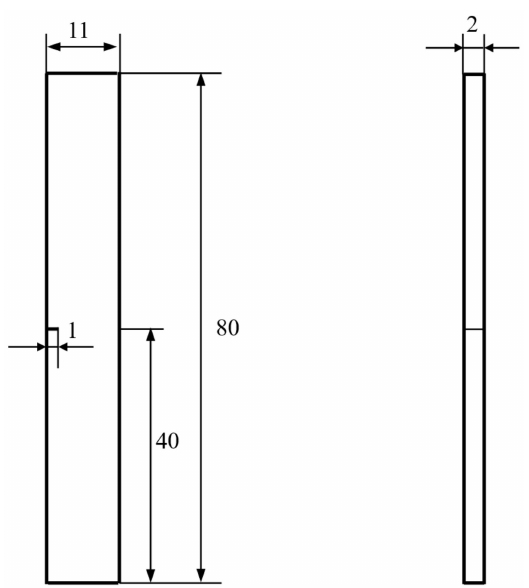
Figure 2. The single edge-cracked bend specimen for the three-point bending fatigue test (unit: mm).